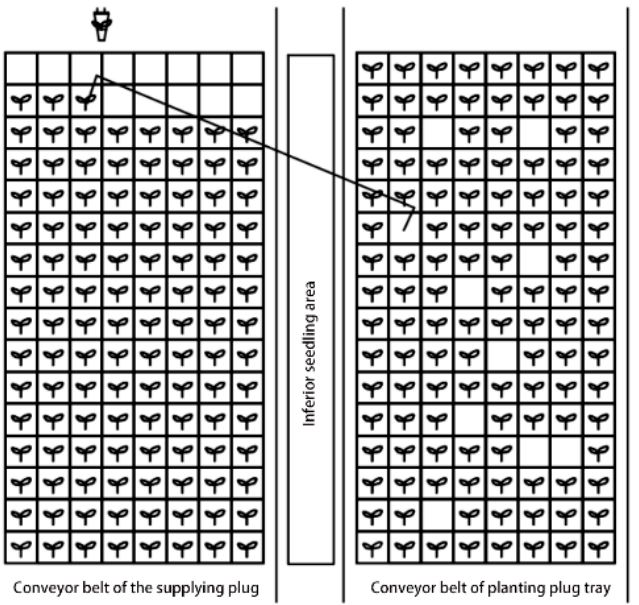
Figure 15. Schematic diagram of removing and supplementing plug seedlings in trays.